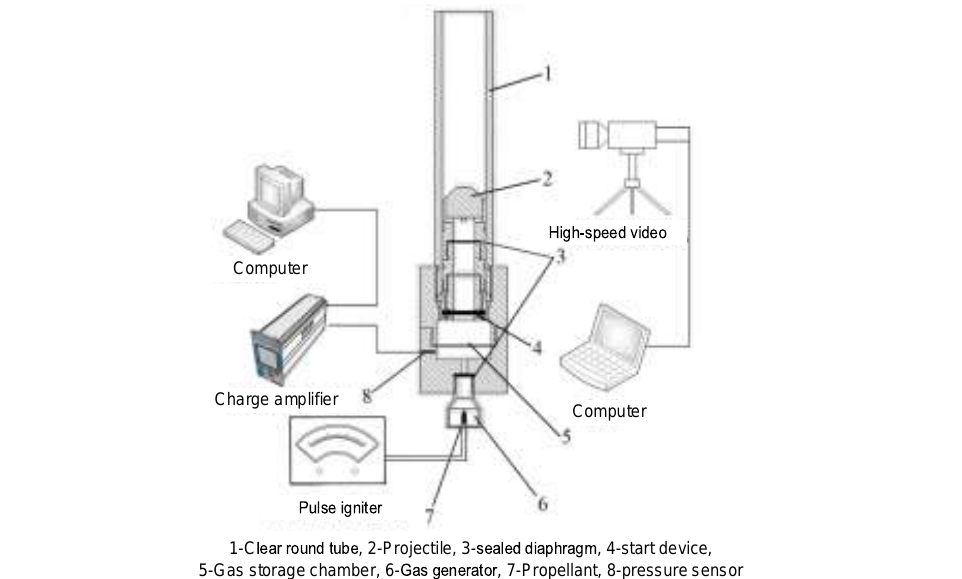
Figure 1. Visual simulated experiment system.